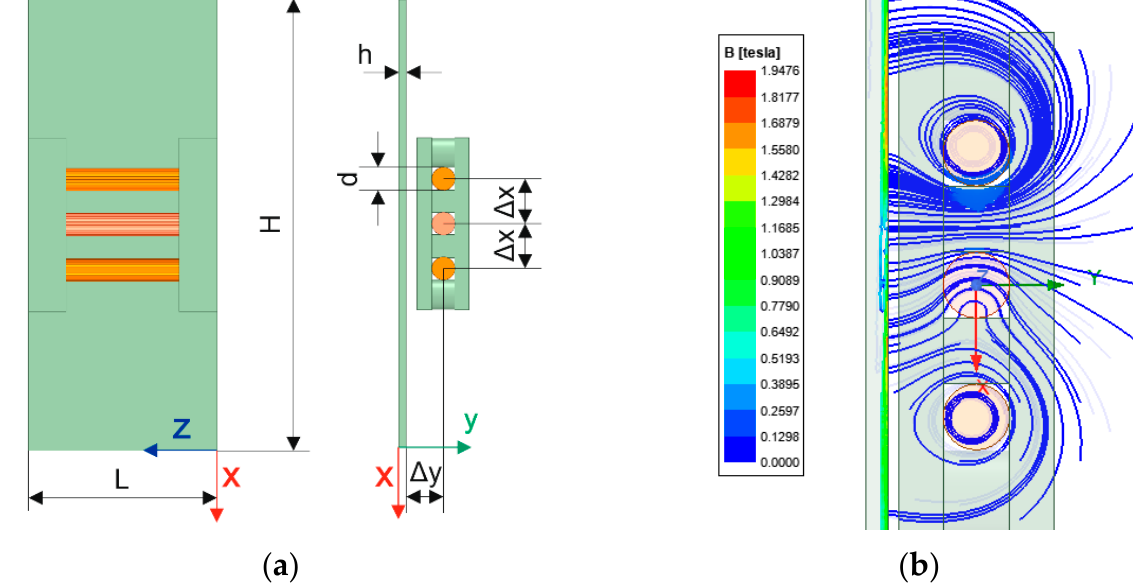
Figure 3. ( a ) Model of 3 cables near magnetic plate in ANSYS Maxwell; ( b ) magnetic flux density for simulation with conductive plate.